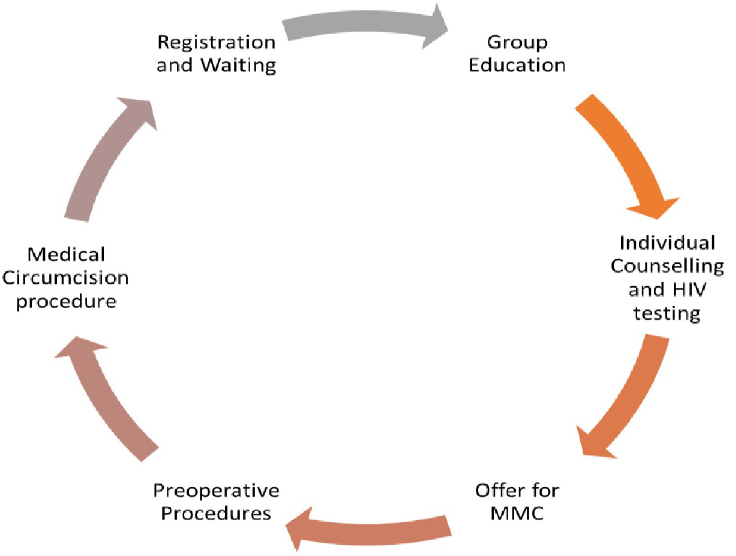
Fig 1. Patient flow for VMMC at site of